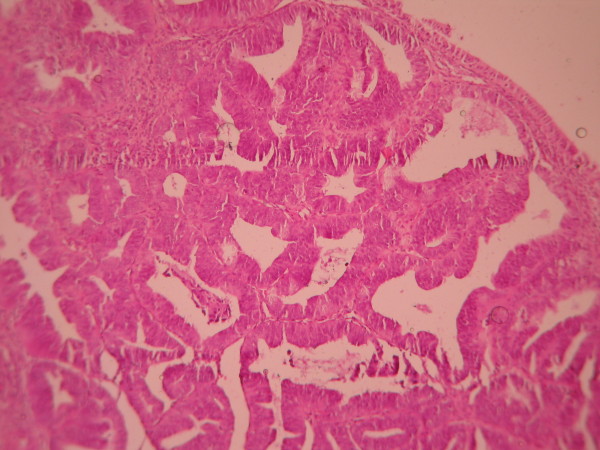
Endometrial adenocarcinoma. Confluent growth pattern of glands with no intervening endometrial stroma. (Low power).